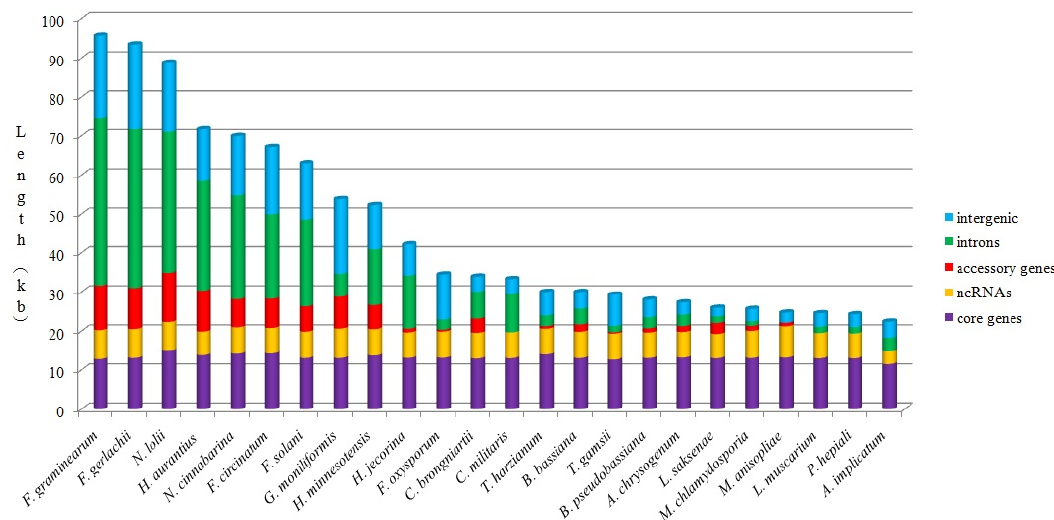
Figure 4. Contributions from intergenic regions, introns, ncRNAs, and core and accessory genes to mitochondrial genome sizes. Blue, green, red, yellow, and purple pillars represent the length of 14 core genes, introns, accessory genes, ncRNAs, and core genes, respectively. Each vertical pillar represents the size of a mitochondrial genome.